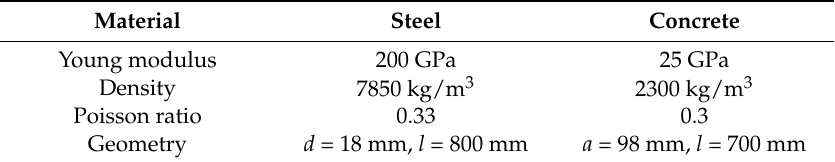
Table 1. The main parameters and geometry of the detecting